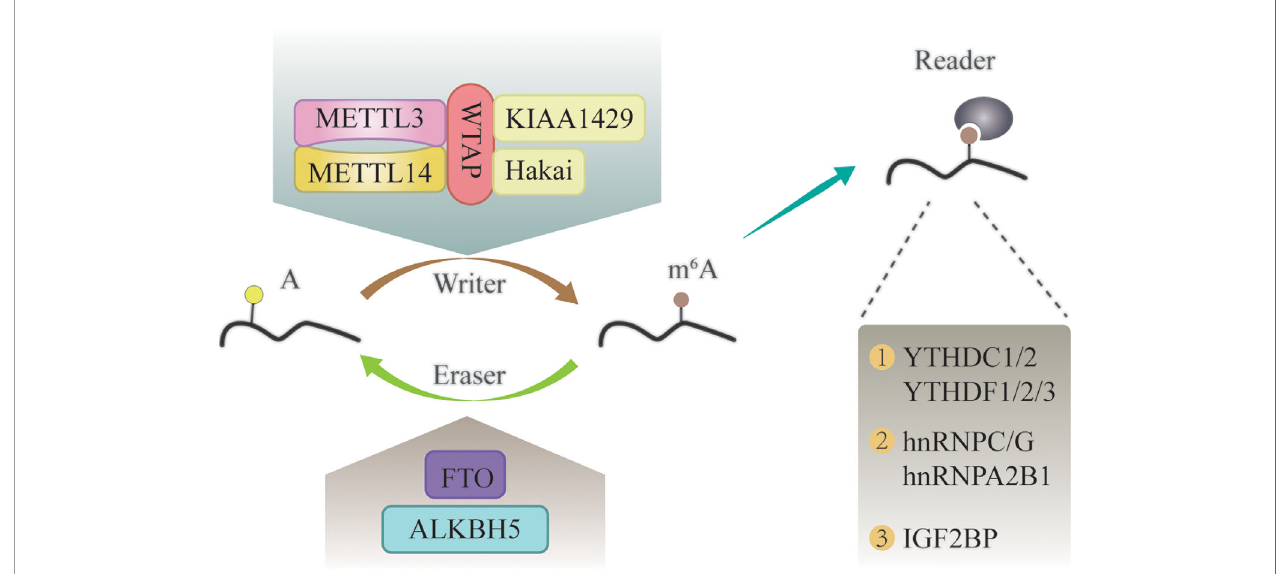
FIGURE 1 | The molecular mechanism of m 6 A modi fi cation. It is a dynamic and reversible epigenetic modi fi cation that is regulated by “ writers ” and “ erasers. ” m 6 A markers in the RNA can be recognized by “ readers ”